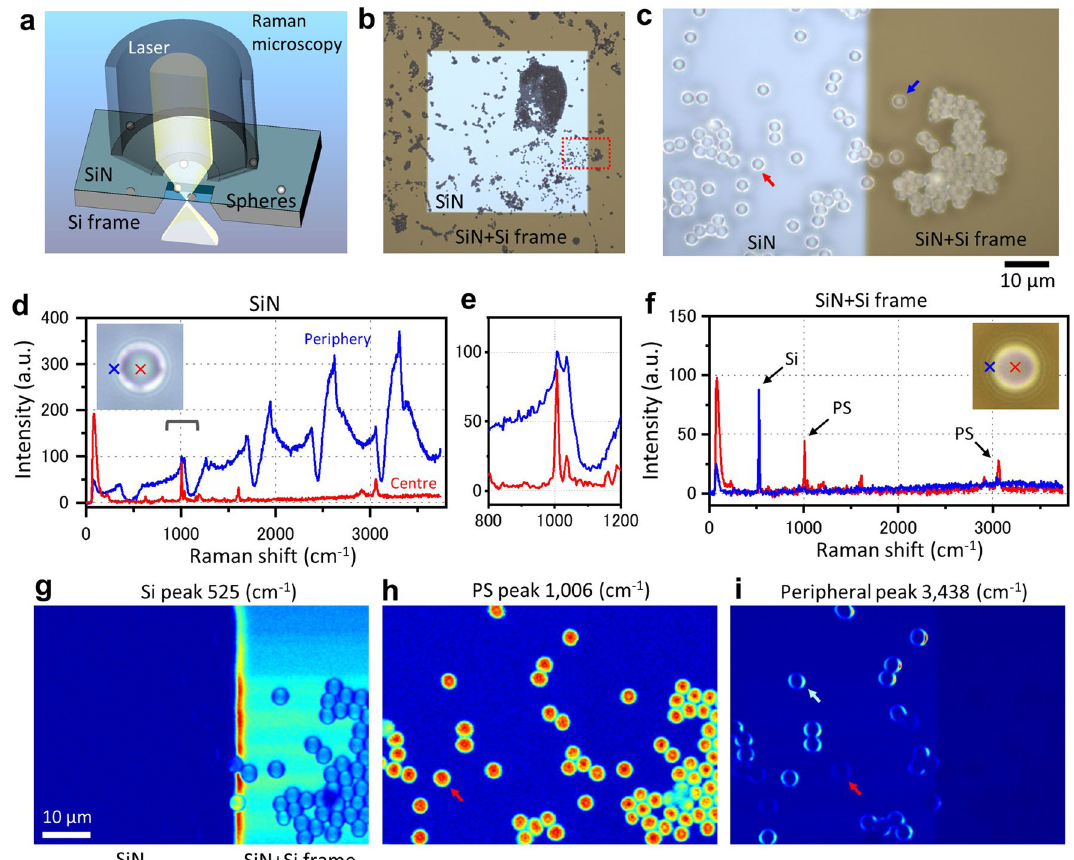
Figure 1. Raman spectrum of PS microspheres on SiN film. ( a ) Schematic of the setup used to measure the Raman spectrum of 3 μm diameter PS spheres on a SiN film of 50 nm thickness supported by a Si frame. ( b ) OM image of the spheres on a 0.4 × 0.4 mm square SiN film. ( c ) Higher magnification OM image (×1000) of the boundary region between the SiN film and the Si frame (dashed red rectangle in b ). ( d ) Raman spectra of the sphere centre (red line) and left periphery (blue line) on the SiN film indicated by a red arrow in ( c ). The sphere centre exhibited a PS spectrum, while the periphery showed a very high intensity spectrum with periodicity. ( e ) Raman spectrum of ( d ) focusing on a range of 800–1200 cm −1 . At the sphere centre, the PS Raman peak of 1006 cm −1 was clear (red line), while the PS peak of the sphere periphery was very low (blue line). ( f ) Raman spectra of the sphere centre (red line) and left periphery (blue line) on the SiN film contacted by a Si frame indicated by a blue arrow in ( c ). Under this condition, similar PS and Si peaks were observed in both Raman spectra. ( g ) Raman image of Si peak (525 cm −1 ) in ( c ). The Si frame on the right side was clearly observed. ( h ) With the Raman image of PS peak (1006 cm −1 ), all spheres in the scanned area were clearly observed. ( i ) With the Raman image of 3438 cm −1 , the spheres on the SiN film showed a ring shape. Scale bars, 10 μm in ( c ) and ( g